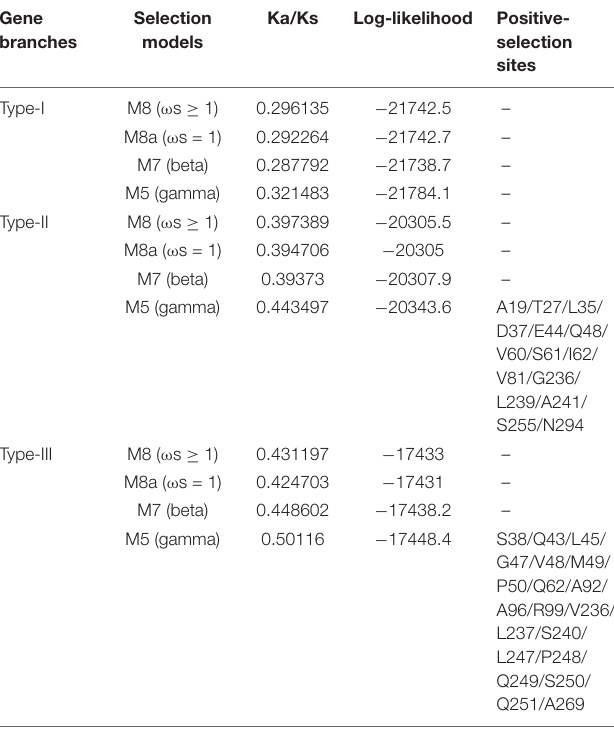
TABLE 3 | Likelihood values and parameter estimation of positive selection among each codon of BnaAHLs .